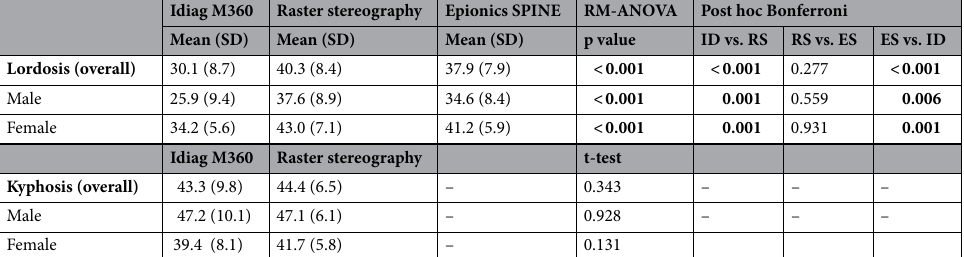
Table 2. Lumbar lordosis and thoracic kyphosis in upright standing for the entire study population (overall) as well as males and females separately. Significant differences (p value < 0.05) are marked in bold. ID Idiag M360, RS Raster stereography, ES epionics